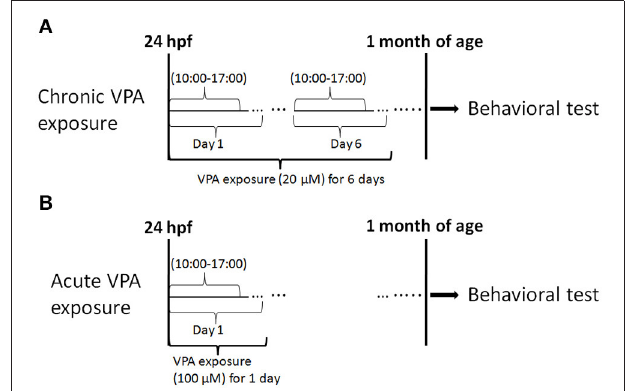
FIGURE 1 | Experimental procedure. This experiment consisted of drug exposure and behavioral testing. (A) Chronic exposure to 20 µ M VPA occurred for 7h (starting at 10:00a.m.) every day from 1 to 6 dpf and behavioral tests were performed at 1 month of age. (B) Acute exposure to 100 µ M VPA was applied for 7h at 1dpf, and behavioral tests were performed at 1 month of age.